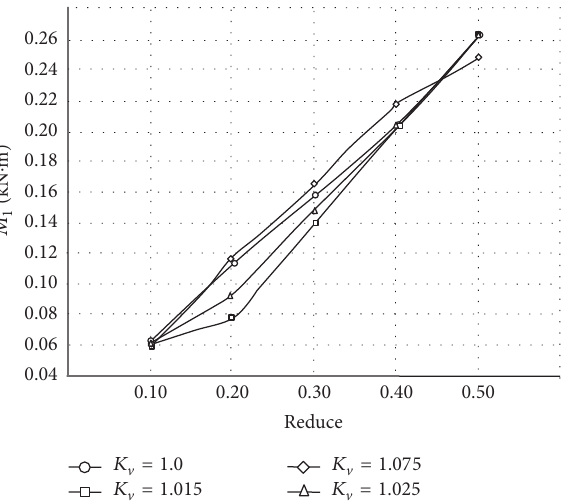
Figure10:Thecalculateddistributionsofthecurrentpulse,depend- ing on the reduce and the speed asymmetry coefficient (the initial thickness of compact material is 0.5